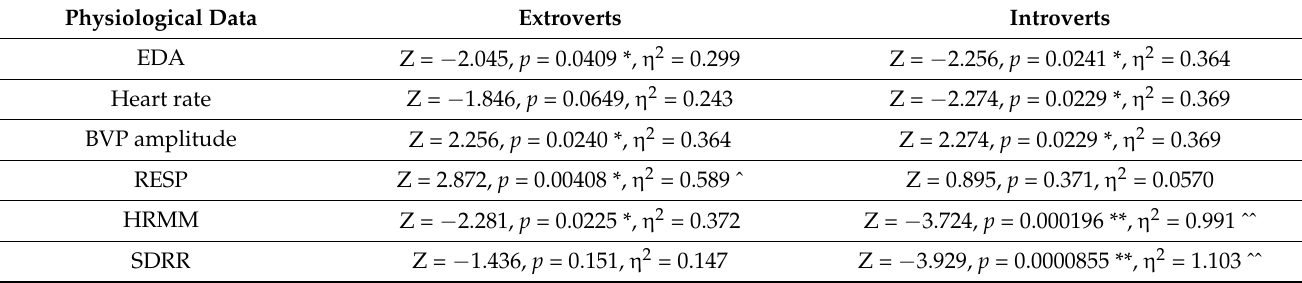
Table 2. Wilcoxon signed-rank tests between REST and TASK for extroverts and introverts. Physiological Data